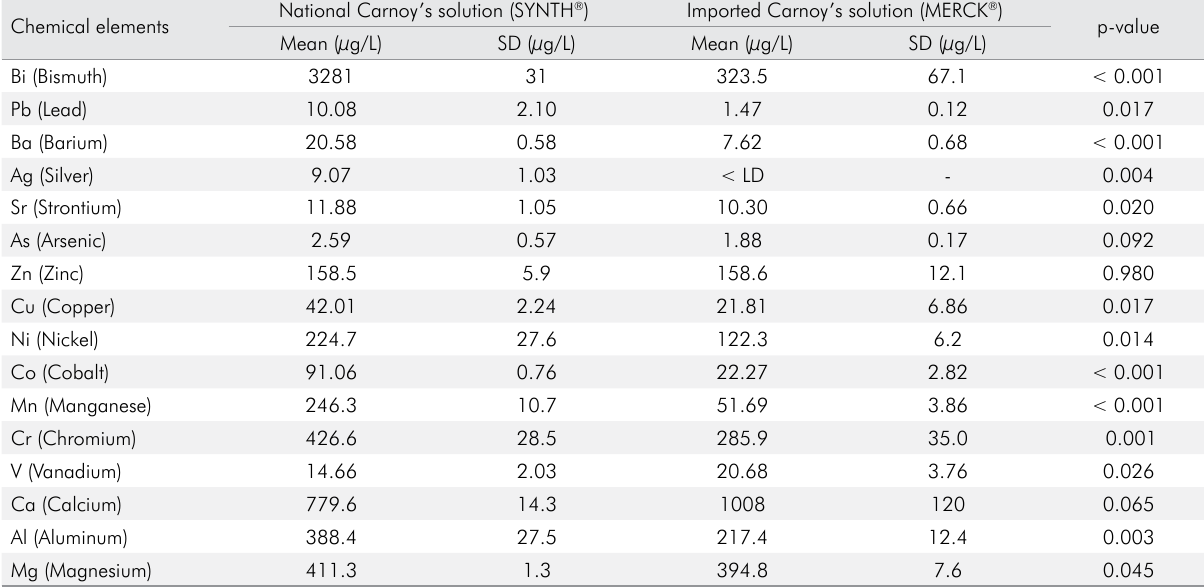
Table 2. ICP-MS results for both national and imported Carnoy’s solutions. Chemical elements